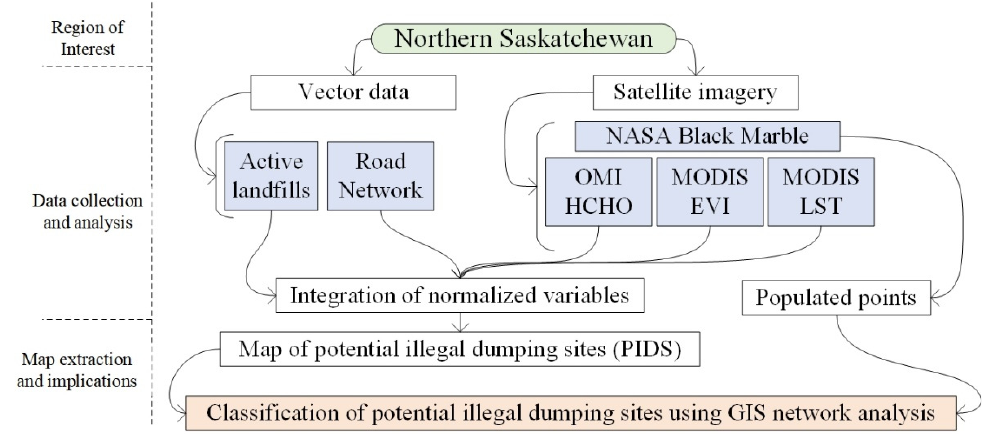
Figure 1. Workflow of current study including regions of interest selection, data collection and analysis, and map extraction and implications.